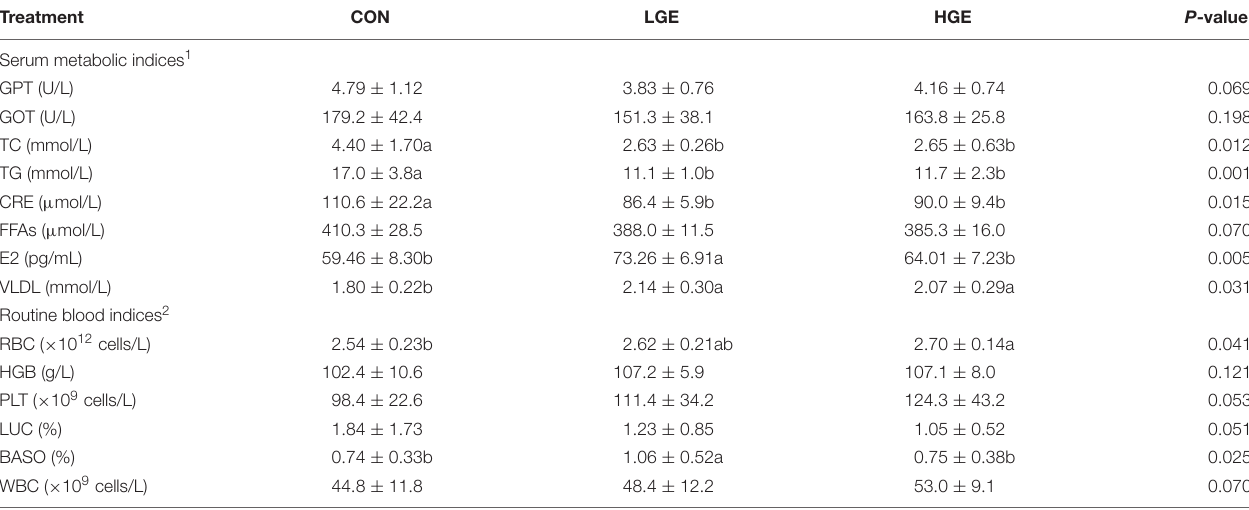
TABLE 4 | Effect of dietary GEN on the serum metabolic indices and routine blood indices of hens. a